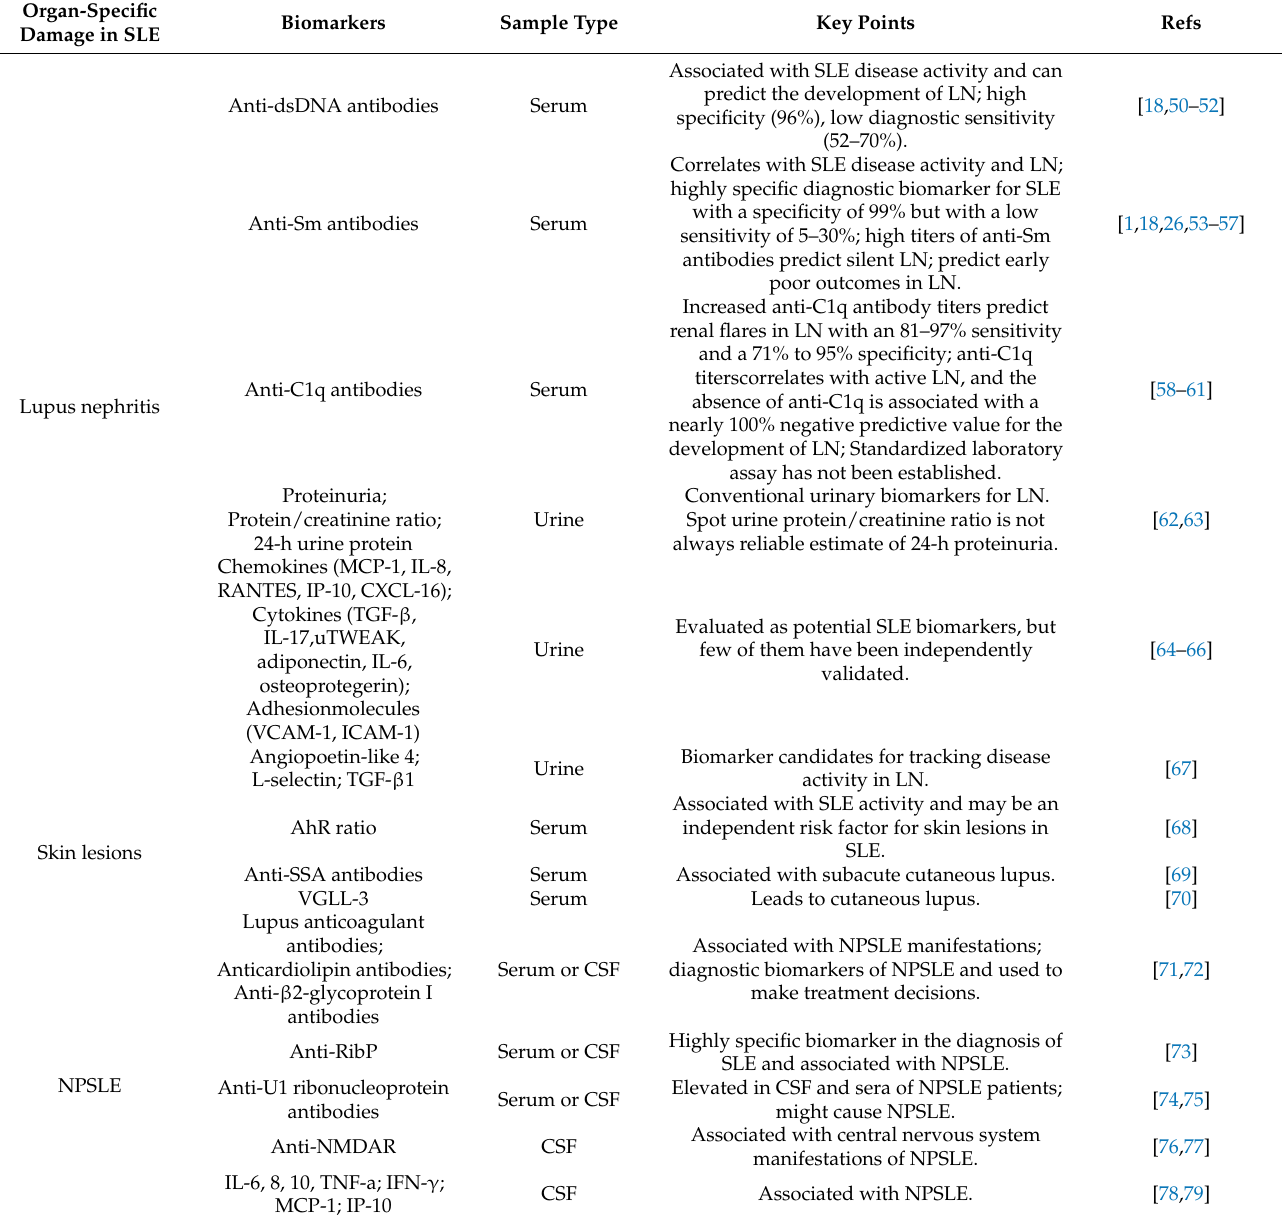
Table 2. Clinical and immunological biomarkers of organ-specific damage in